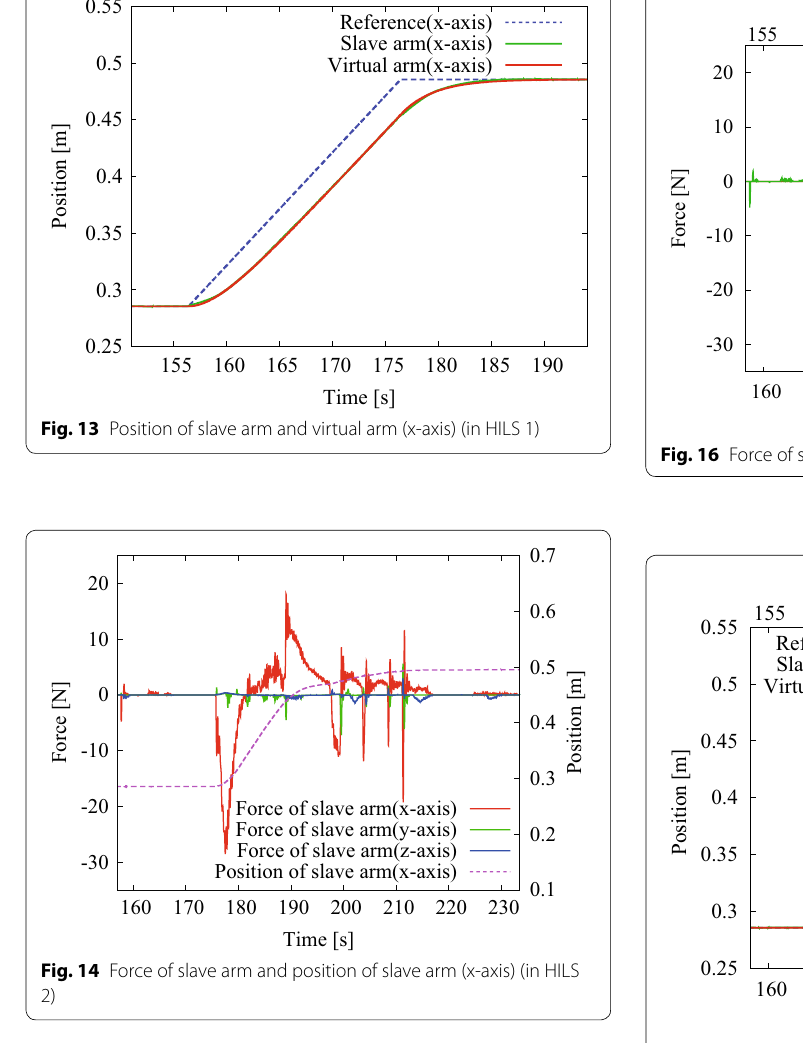
Fig. 17 Position of slave arm and virtual arm (x-axis) (in HILS